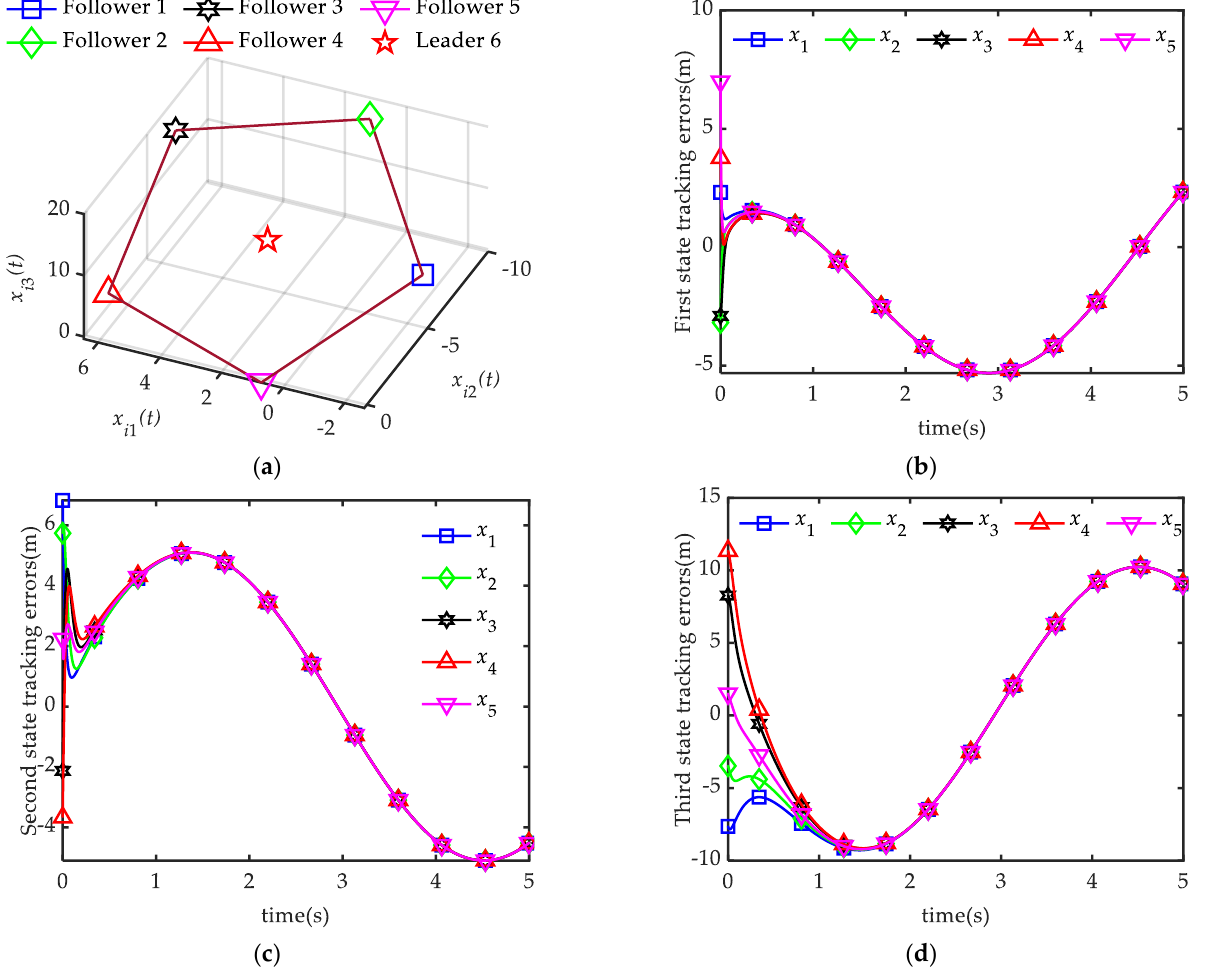
Figure 5. States snapshot of all the agents when t = 5 s and state errors x i − h i , i = 1,2, · · · ,5 of five followers without external disturbances. ( a ) States snapshot of all the agents when t = 5 s; ( b ) First state errors x i 1 − h i 1 , i = 1,2, · · · ,5; ( c ) Second state errors x i 2 − h i 2 , i = 1,2, · · · ,5; ( d ) Third state errors x i 3 − h i 3 , i = 1,2, · · · ,5.